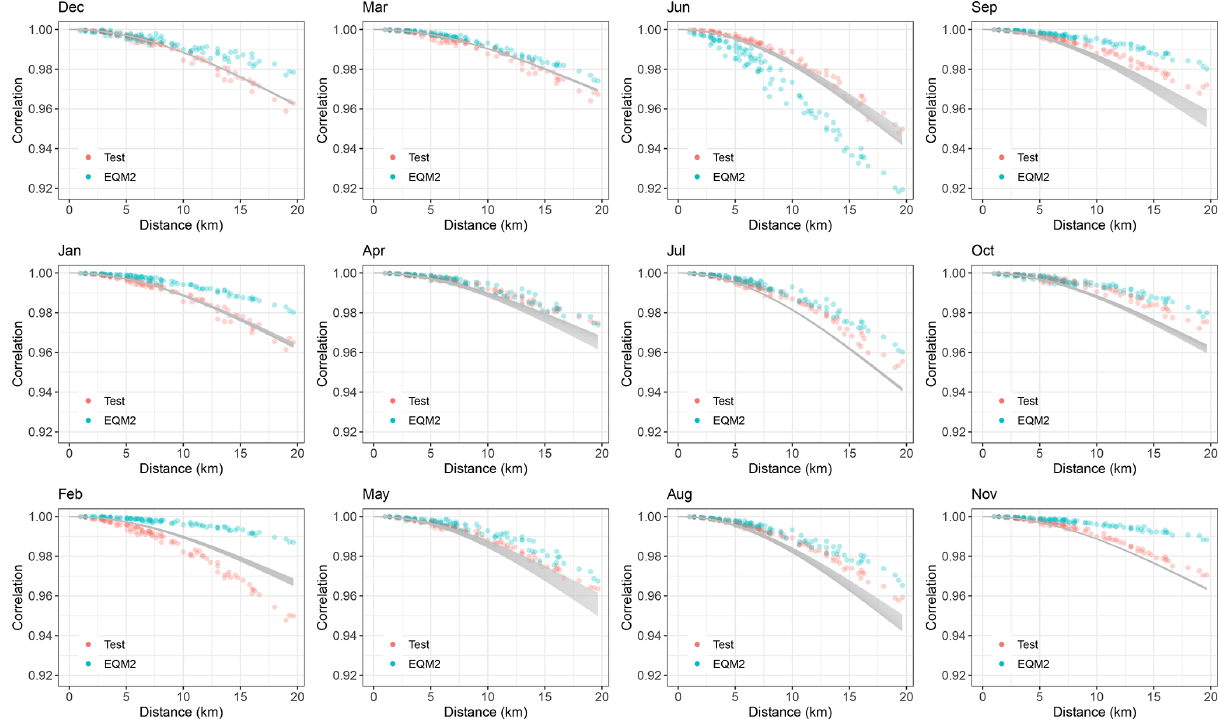
Figure 7. Empirical spatial correlation of precipitation amount at the catchment Kjeldstad for each month of the year. Results are shown for the seNorge data in the test period 1987–2005 (red dots) and for the EQM simulation based on RCM2 (cyan dots). The Matérn spatial correlation estimated with the WG method based on seNorge data in the training period 1957–1986 is indicated in grey, with the width of the bar indicating the spread of the daily estimates within the